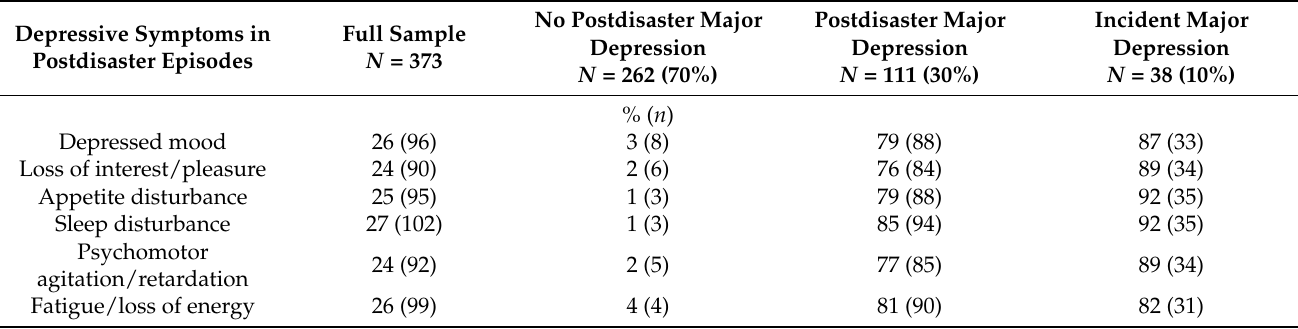
Table 2. 9/11 database prevalence of postdisaster depressive